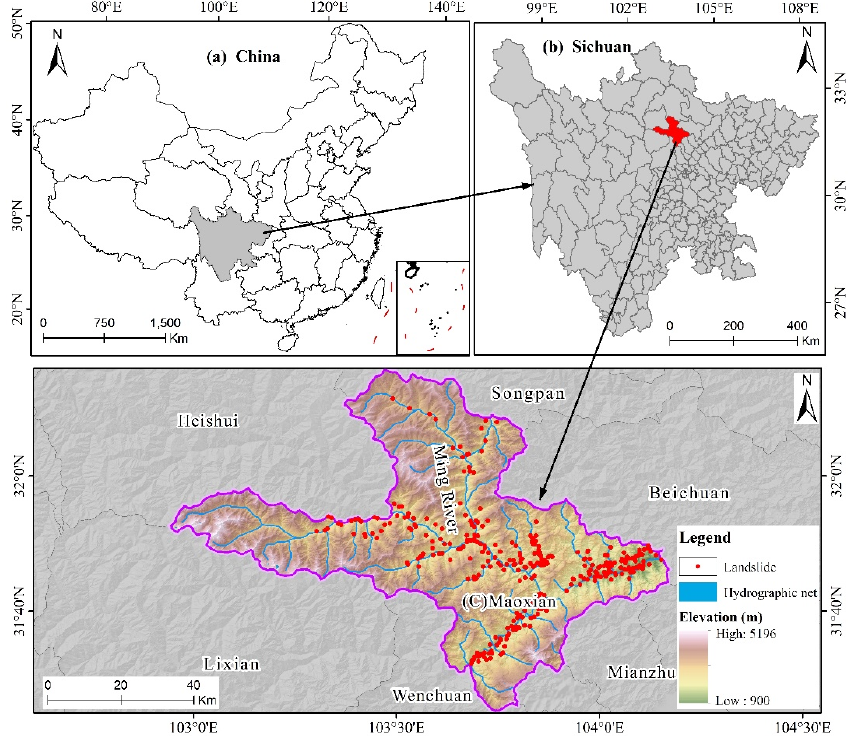
Figure 1. Maps of the study area: ( a ) Location within China; ( b ) Location within Sichuan Province; ( c ) Locations and distribution of landslides in the study area.